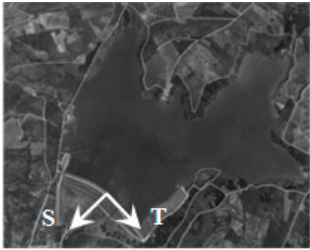
Figure 12. Local reference system (T and S indicate directions tangential and orthogonal to the dam).